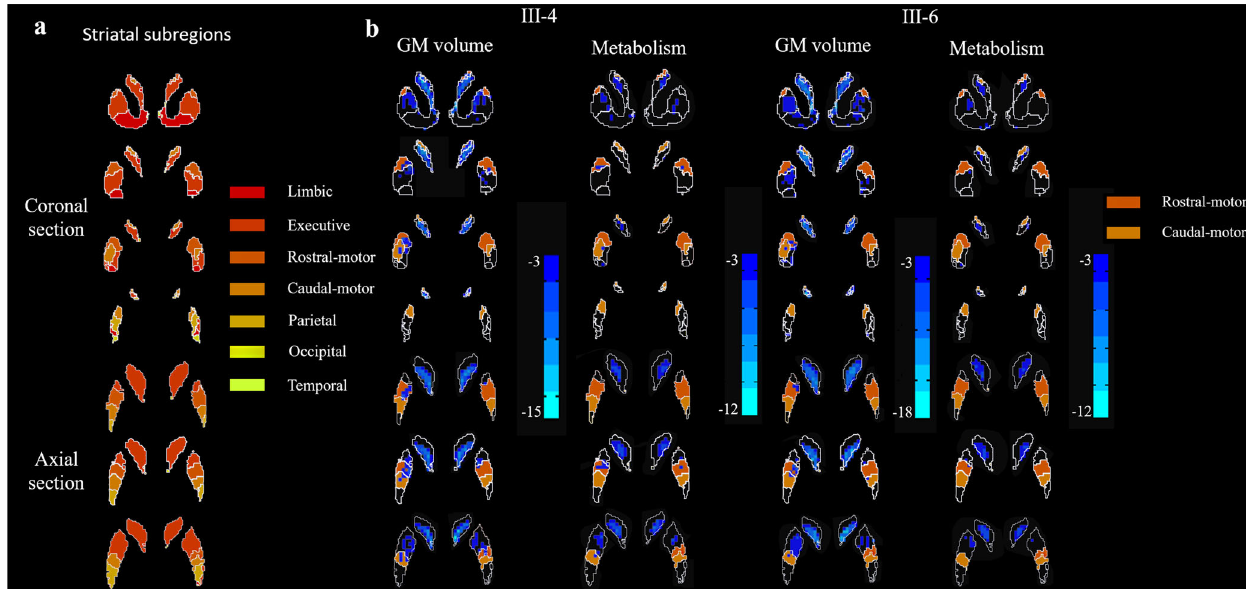
Fig. 2 GM atrophy and hypometabolism pro fi les in functional subregions of the striatum. a The striatal parcellations based on intrinsic functional connectivity to the cerebral cortex. Colors indicate functional subdivisions into the limbic, executive, sensorimotor, rostral-motor, caudal-motor, parietal, occipital, and temporal subdivisions. b Blue color corresponds to patterns of gray matter loss and hypometabolism in the FTDP patients compared to controls. Results are shown after correction for multiple comparisons using FDR p < 0.05. VBM analysis indicated signi fi cantly greater atrophy in the rostral-motor and caudal-motor regions of our FTDP patient (III-4) compared to the healthy controls. Similarly, voxel-wise examinations revealed hypometabolism in the rostral-motor and caudal-motor subregions compared to healthy controls, taking age and sex as covariates. In the other patient (III-6), signi fi cant GMV loss was also observed in the rostral-motor and caudal- motor subregions. However, no signi fi cant hypometabolism was observed in the rostral-motor and caudal-motor subregion.